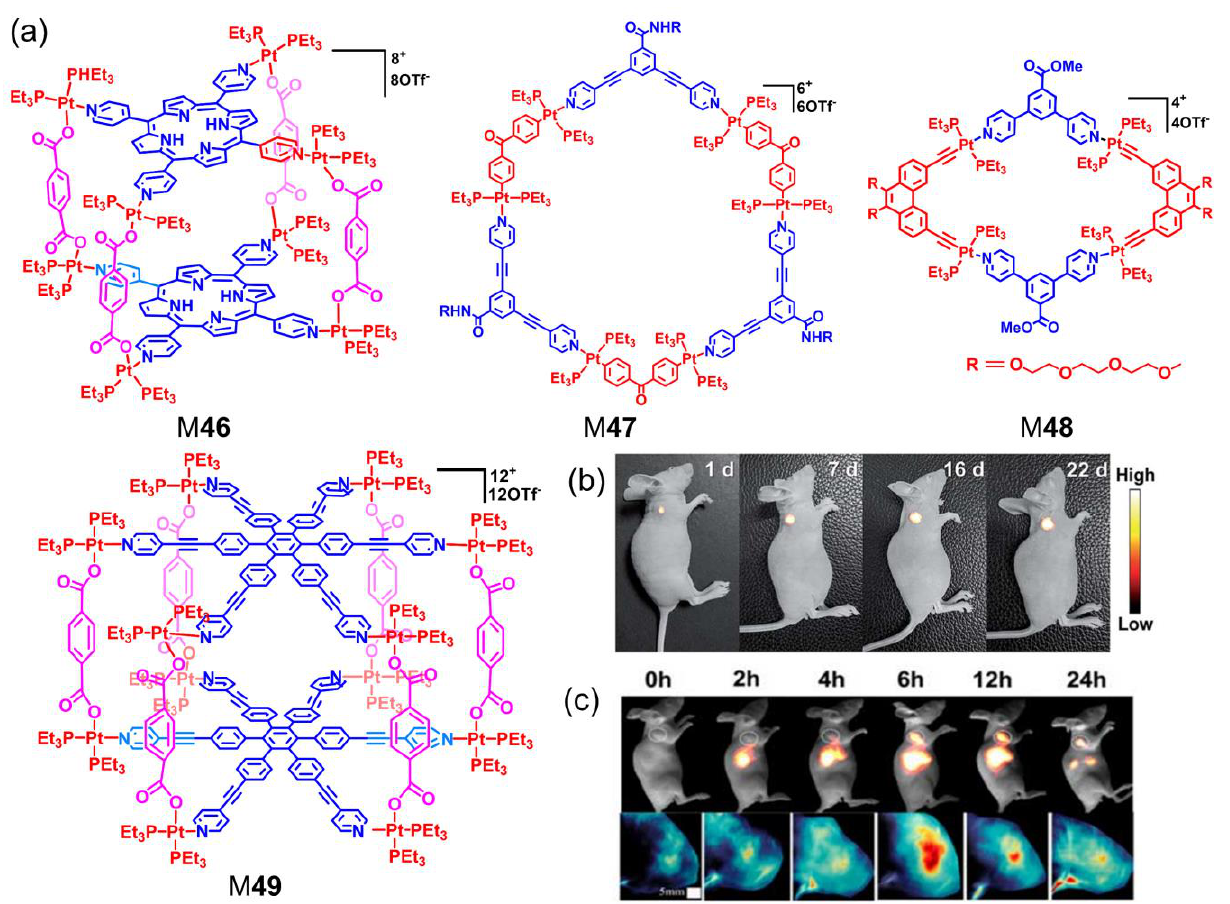
Figure 9. ( a ) The structures of M 46 − M 49 . ( b ) NIR-II fluorescence images of the M 47 -based nanotheranostic agent therapeutic response in U87MG tumors. ( c ) NIR-II fluorescence and PA images of M 48 -NPs at different times. Adapted with permission from refs. [16,121–123]. Copyright 2019 National Academy of Sciences (USA); 2019 Royal Society of Chemistry; 2018 Nature Publishing Group.